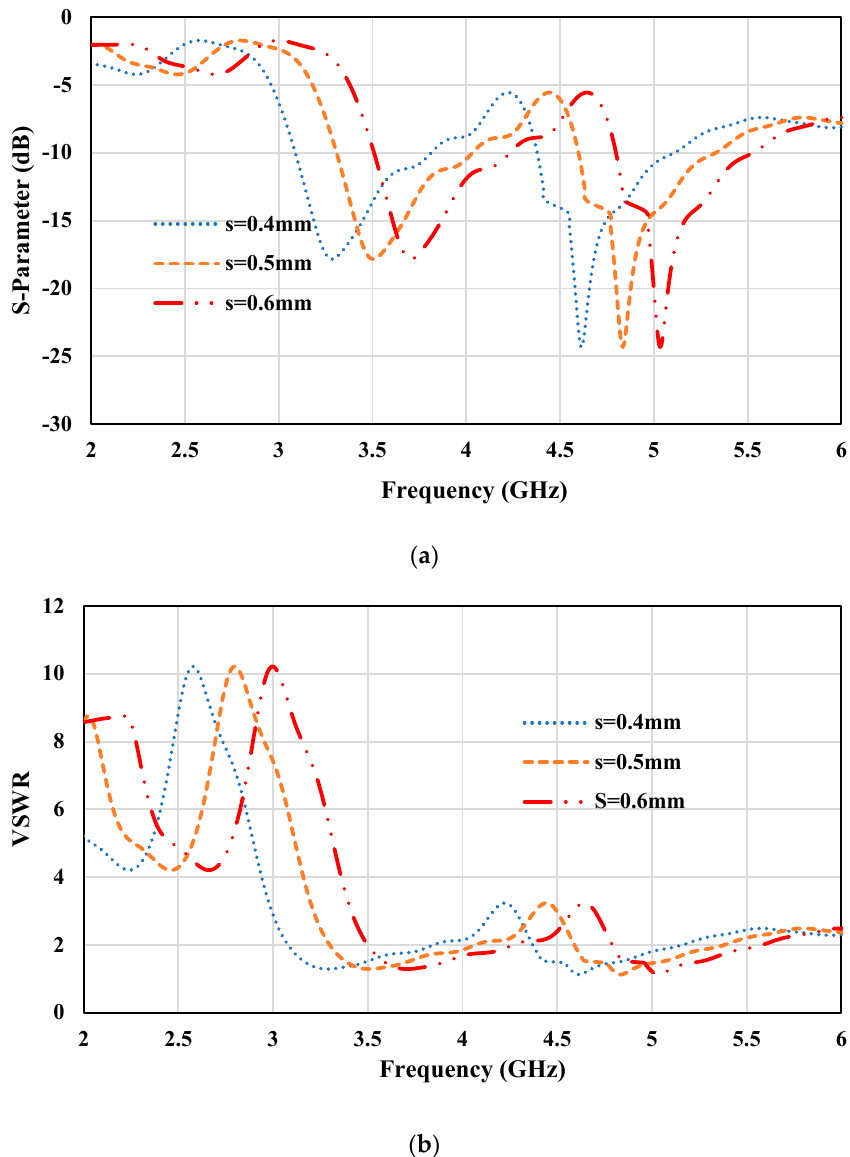
Figure 5. Simulated characteristics of the proposed antenna by varying the TCSSR slot width s ( a ) return − loss ( b ) VSWR. Table 2. Operating frequency and notch bands for different values of s.